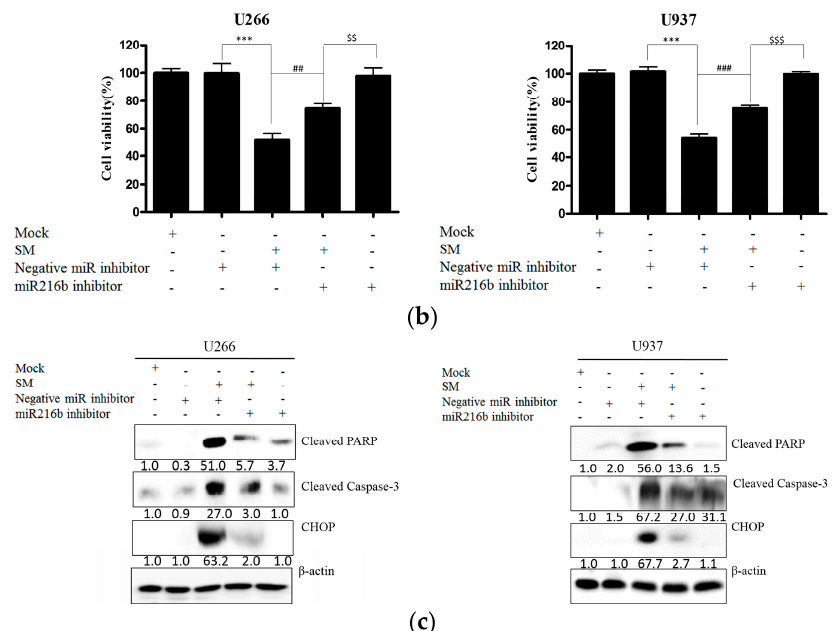
Figure 6. MiR-216b inhibition reversed the apoptotic effect of SM in U266 and U937 cells. ( a ) Cells were transfected with miRNA inhibitor negative control (Negative miR inhibitor) or miR-216b inhibitor and treated with SM (50 µg/mL) for 24 h. Real-time PCR for miR-216b expression was conducted. Values represent the means of three experiments ± SD; ***, p < 0.001 versus the miRNA inhibitor negative control group; ## , p < 0.01; ### , p < 0.001 versus miR-216b inhibitor-transfected and SM-treated group; $$$ , p < 0.001 versus miR-216b inhibitor-transfected group; ( b ) The cell viability assay was performed with miR-216b-inhibited and 50 µg/mL of SM-treated cells. Values represent the means of three experiments ± SD; ***, p < 0.001 versus the miRNA inhibitor negative control group; ## , p < 0.01; ### , p < 0.001 versus the miR-216b inhibitor-transfected and SM-treated group; $$ , p < 0.01; $$$ , p < 0.001 versus the miR-216b inhibitor-transfected group; ( c ) Cells were transfected with miRNA inhibitor negative control or miR-216b inhibitor and treated with 50 µg/mL of SM for 24 h. Western blot analysis was conducted for cleaved PARP, cleaved caspase-3, and CHOP. Mock, group treated with transfection reagent only; SM, SM-treated group.